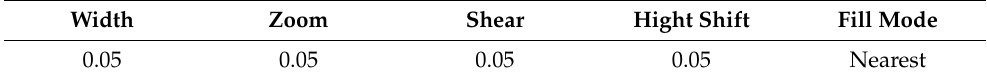
Table 11. Augmentations parameters.